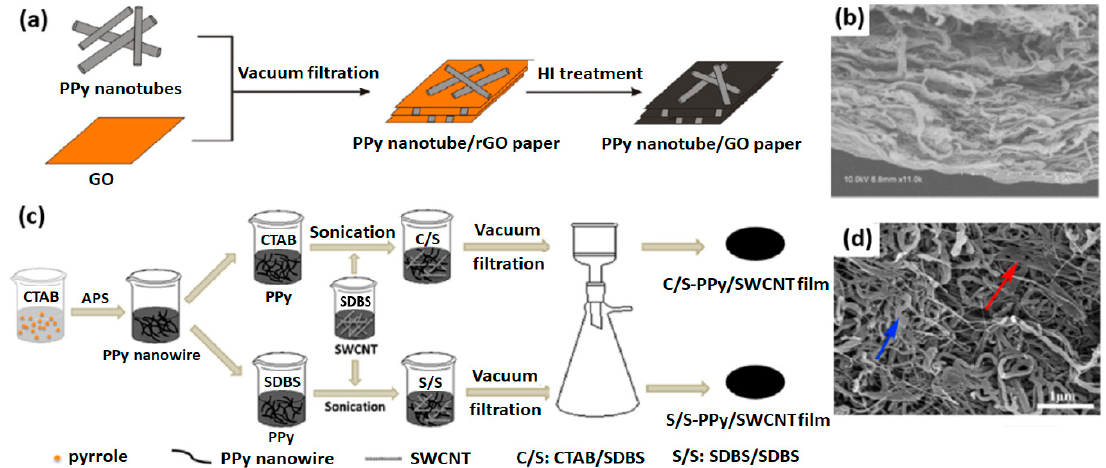
Figure 14. ( a ) Schematic of the synthesis procedure of PPy/rGO hybrid film. ( b ) Cross-sectional SEM image of the PPy/rGO hybrid film with a mass ratio of PPy:GO 1:0.6. ( c ) Schematic illustration of the preparation process for the PPy-nanowire/SWCNT nanocomposite free-standing films by solution mixing and subsequent vacuum filtration. ( d ) SEM image of the S/S-PPy nanowire/SWCNT composite films with SWCNT:PPy-nanowire mass ratio of 60 wt%. The arrows in blue point to the PPy nanowires, while the red arrows point toward the SWCNTs. Readapted with permission from Elsevier Ltd [102–103].